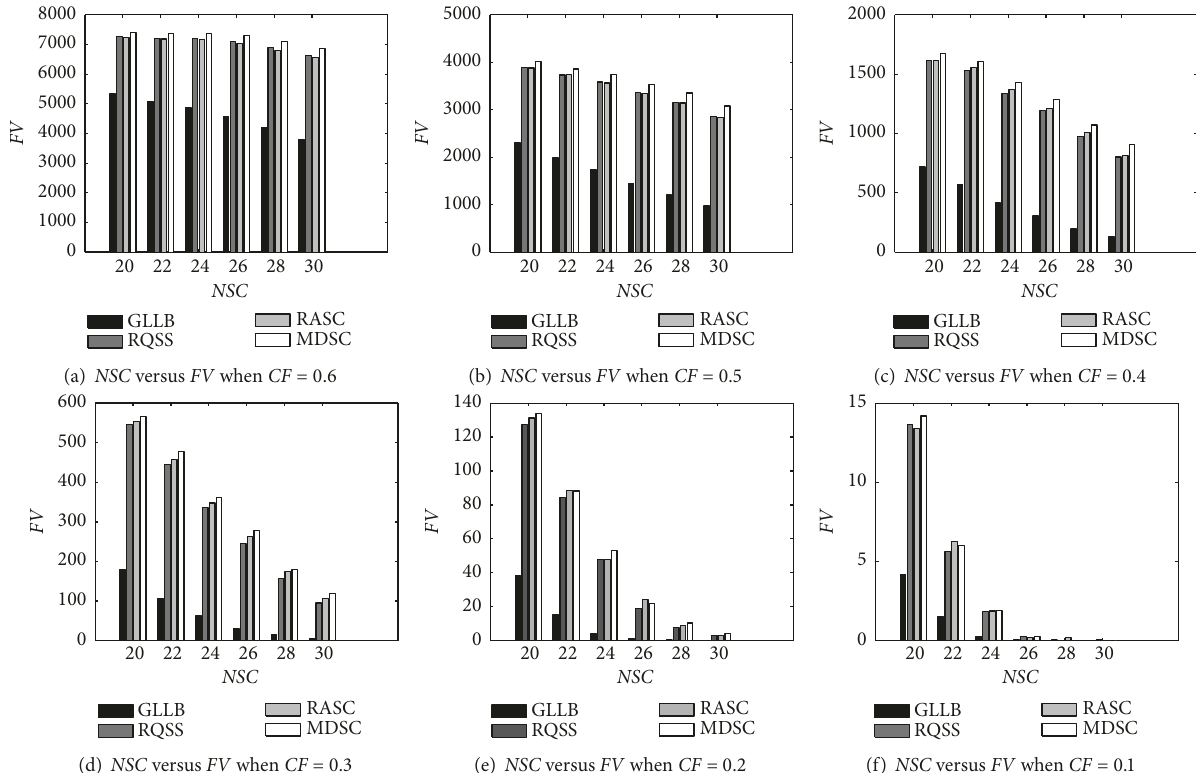
Figure 5: The total Failure value to the soft QoSs of different